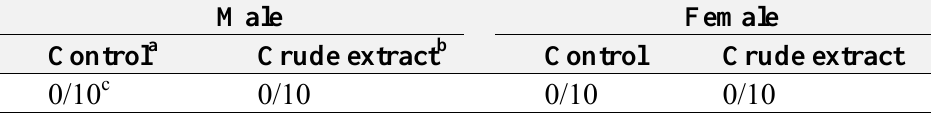
Table 1. Potential toxic effects of the crude extracts of Elaeis guineensis in mice.